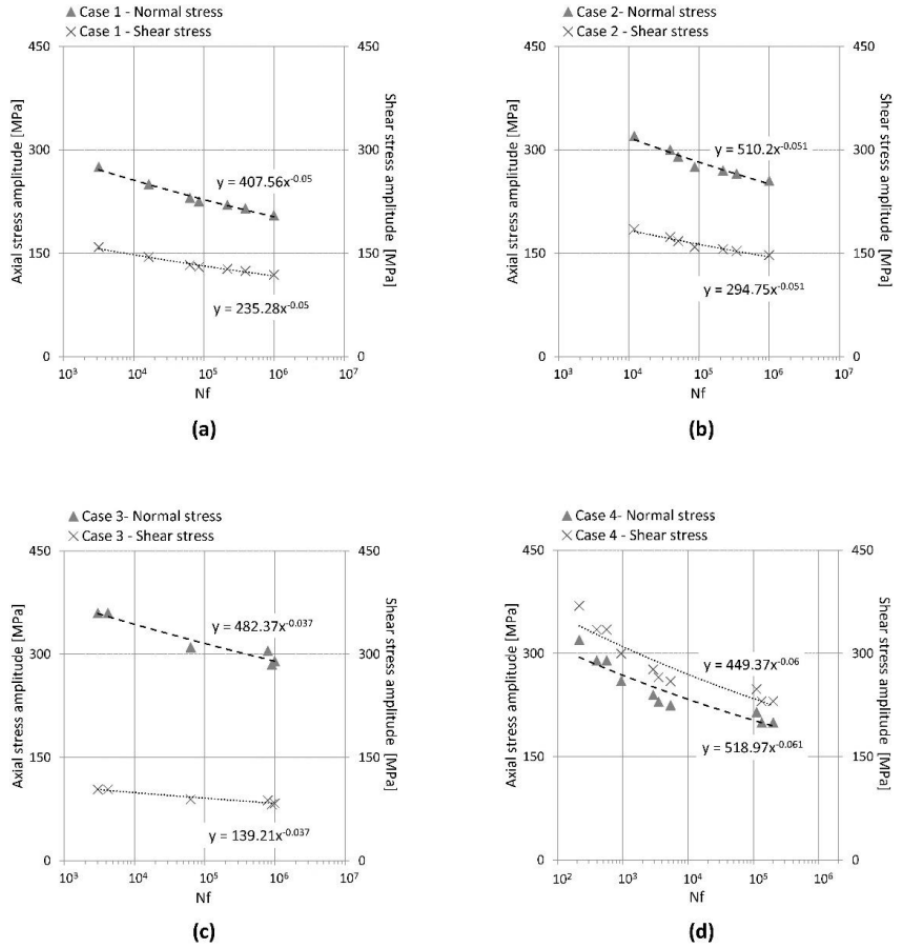
Figure 4. S-N experimental data and respective trend lines representation for loading cases 1 to 4. ( a ) Case 1 PP λ = 0.57, ( b ) Case 2 OP λ = 0.57, ( c ) Case 3 OP λ = 0.29, ( d ) Case 4 OP λ =